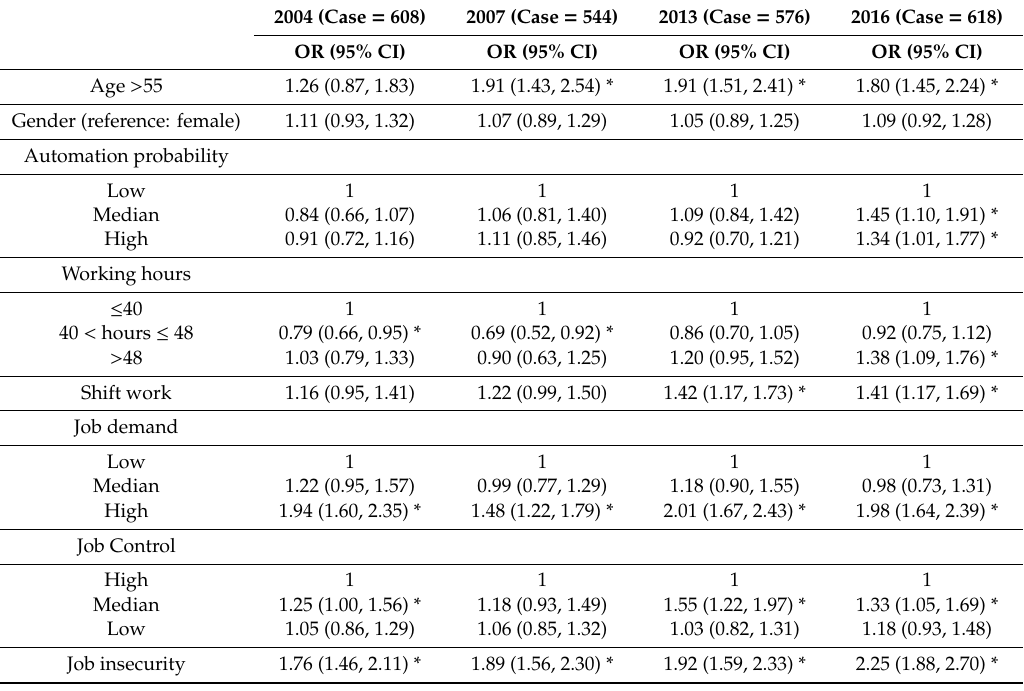
Table 2. Odds ratio and 95% confidence interval (95% CI) for poor self-rated health in the survey years, n = 15,288, 17,042, 16,530, and 14,948, respectively.